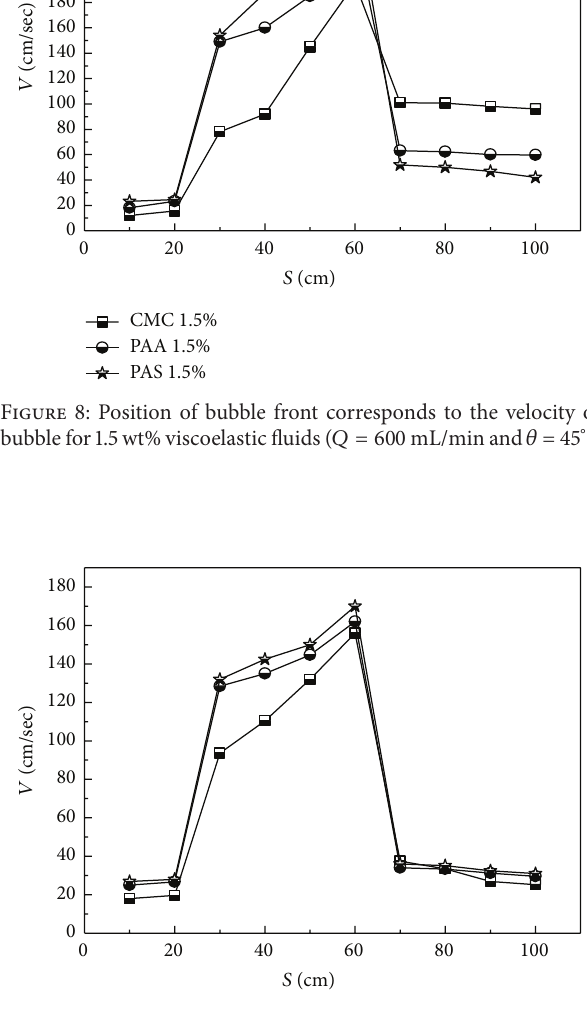
sudden expansion section, its velocity was in the sequence of CMC > PAA > PAS. Here, the shear rate exceeded 20/s. The difference was caused by shear viscosity. Figure 3 shows the main cause of the phenomenon. When viscoelastic fluid was 1.5 wt% and shear rate was lower than 20/s, the shear viscosity was in the sequence of PAS > PAA > CMC.